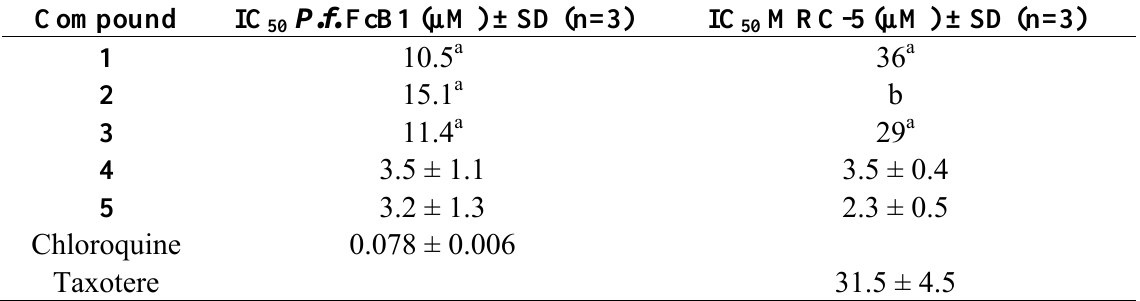
values of compounds 1 - 5 tested against FcB1 strain of P. falciparum and Table 1. IC 50 MRC-5